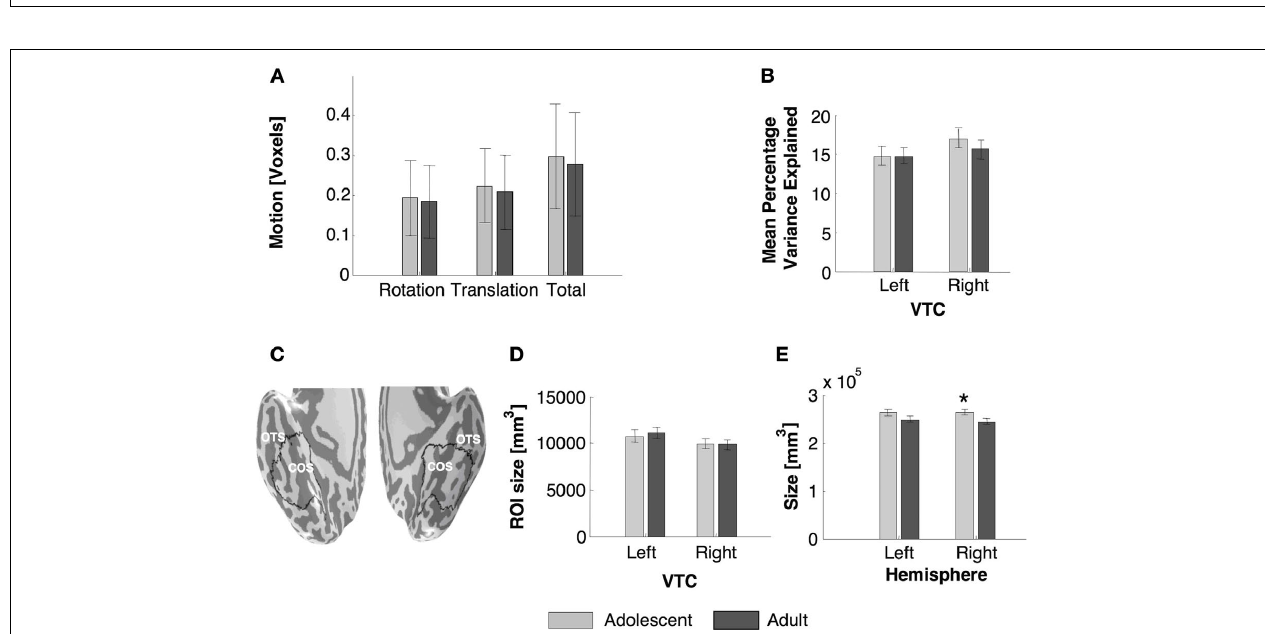
FIGURE 2 | Measurements of BOLD-related confounds and anatomical size of VTC and total hemispheric gray matter across age groups. (A) Motion during scan for each age group. (B) Average variance explained by the GLM model in the anatomical ROI of ventral temporal cortex (VTC) as shown in (C) . The variance explained was measured for each voxel and then averaged across the ROI and across subjects. (C) Representative VTC ROI in an